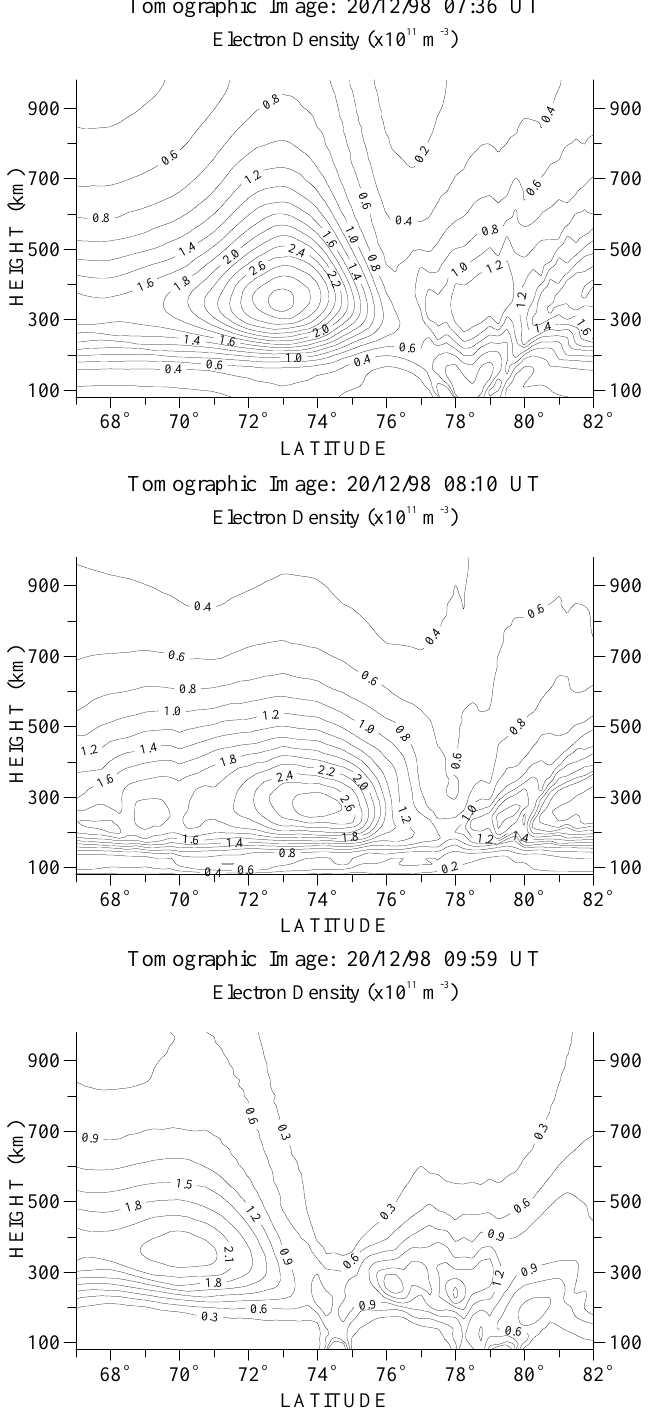
Fig. 8. Tomographic images for three satellite passes that crossed 75 ◦ N at 07:36 UT (top panel), 08:10 UT (centre panel) and 09:59 UT (bottom panel) on 20 December 1998. The reconstruc- tion in the centre panel has been obtained from the total electron content illustrated in Fig.